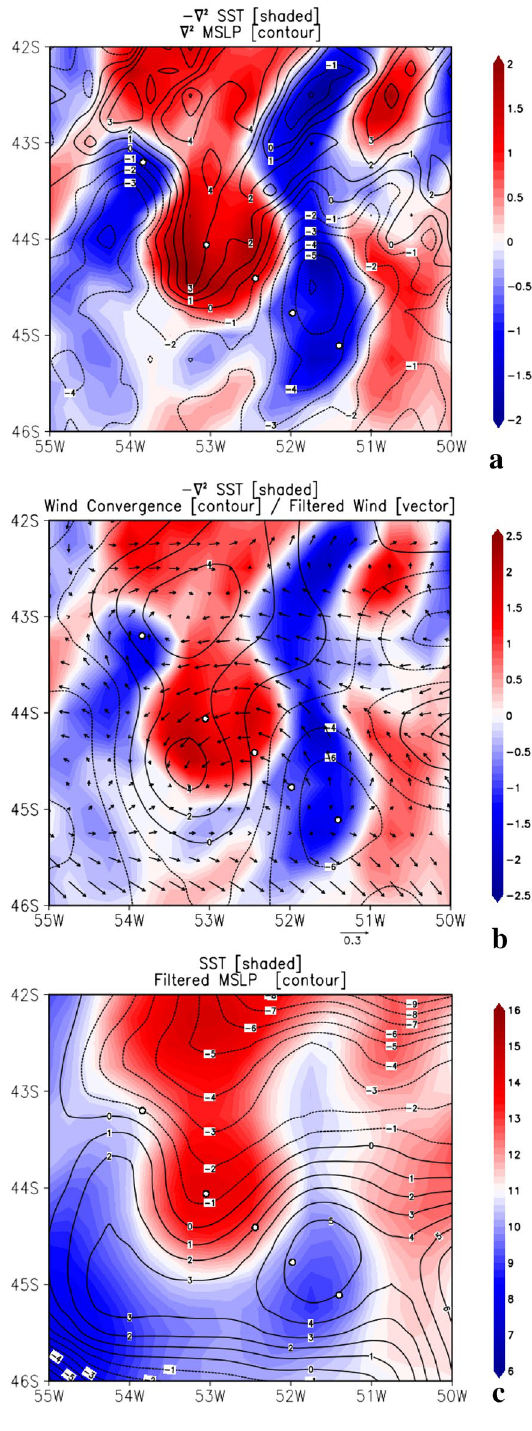
Figure 5. Maps of 10-day-averaged surface atmospheric and oceanic variables from ECMWF ERA5 reanalysis. a) negative Laplacian of Sea Surface Temperature (− ∇ 2 SST 10 −9 K m -2 ) is shaded and Sea Level Pressure ( ∇ 2 SLP 10 −9 Pa m -2 ) is contoured. (b) Laplacian of Sea Surface Temperature (- ∇ 2 SST 10 −9 K m -2 ) is shaded, wind convergence ( ∇ w 10 –6 s -1 ) is contoured and high-pass-filtered field of wind (vectors). c) Sea Surface Temperature (°C) is shaded and high-pass-filtered field of Sea Level Pressure (hPa) is contoured. Grid Analysis and Display System (GrADS), Version 2.2.1.oga.1. http:// openg rads.